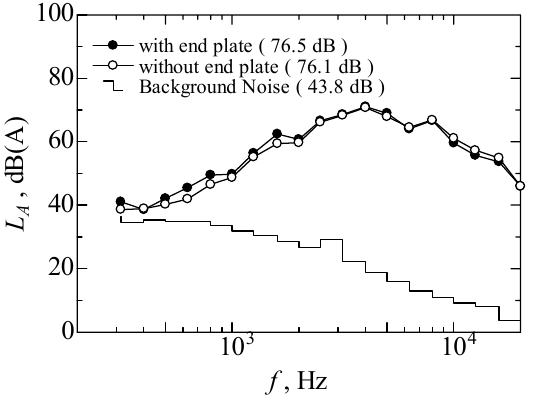
Fig. 3 Comparison on the spectrum distribution of a white